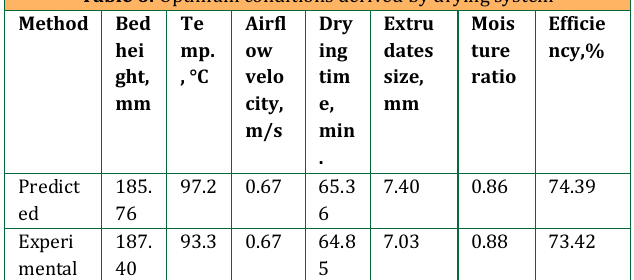
Table 6: Optimum conditions derived by drying